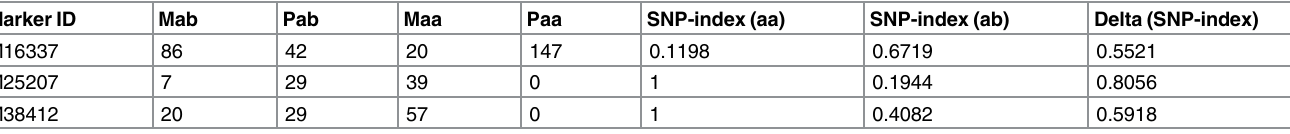
Table 5. SNP-index information of the three markers. Marker ID